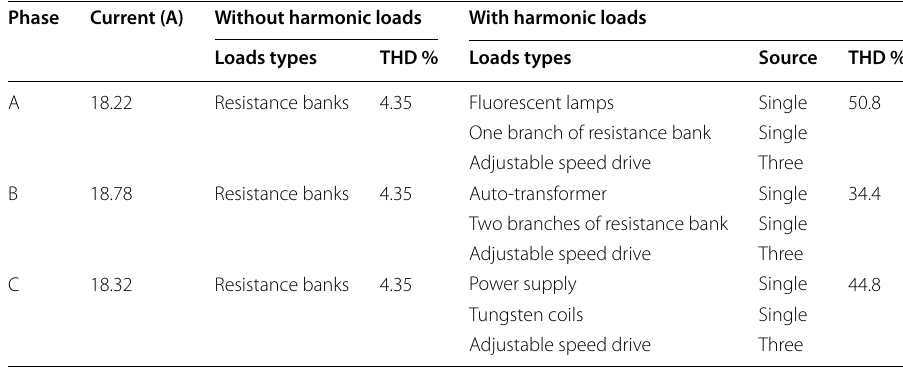
Table 2 Current and total harmonic distortion on each phase Phase Current (A) Without harmonic loads